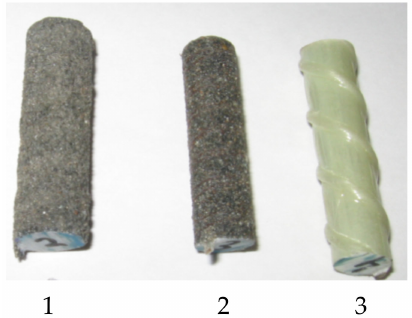
plastic mixture; 2 —same d = 8 mm; 3 —traditional reinforcement bar d = 8 mm made of fiberglass, with two-start coiling (transverse